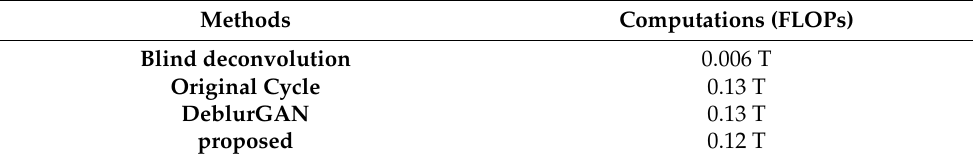
Table 3. Comparison of computational cost of different deblurring methods.